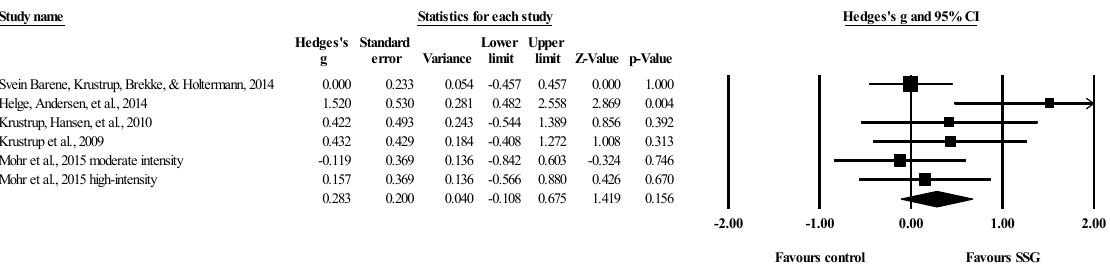
Figure 4. Forest plot of changes in total body bone mineral density in untrained adults after a training program based on soccer small-sided games (SSG) compared to active controls. Values shown are effect sizes (Hedges’s g) with 95% confidence intervals (CI). The size of the plotted squares reflects the statistical weight of each study. The black diamond reflects the overall